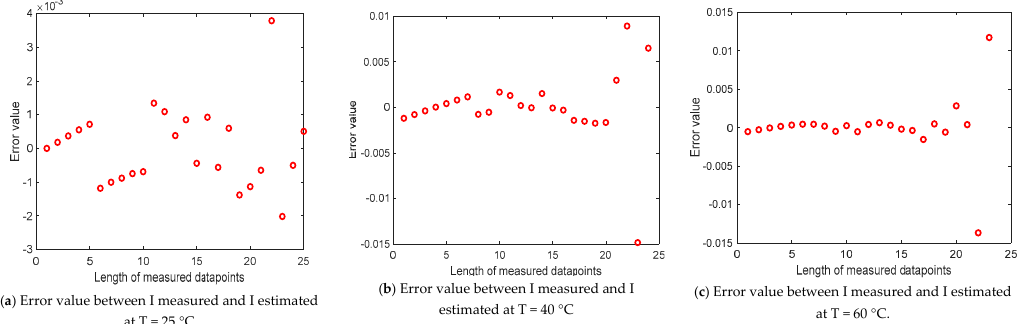
Figure 13. Depiction of error value between all I measured and estimated data on SDM for the SM55 module at different T and G = 1000.